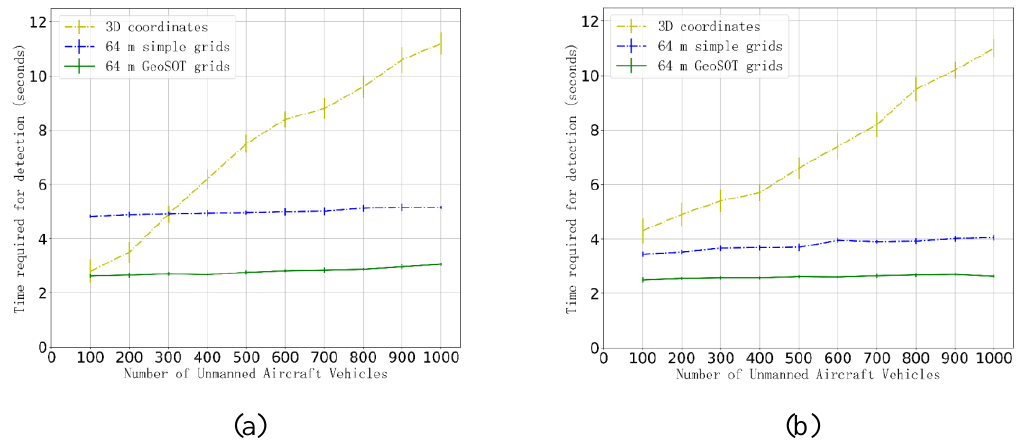
Figure 8. Time required to detect collisions with three methods in an airspace containing obstacles. In simulation experiment ( a ), a 1 km × 1 km × 1 km obstacle was placed at the center of the airspace. In simulation experiment ( b ), 100 obstacles of the same size as the UAVs were placed within the airspace.